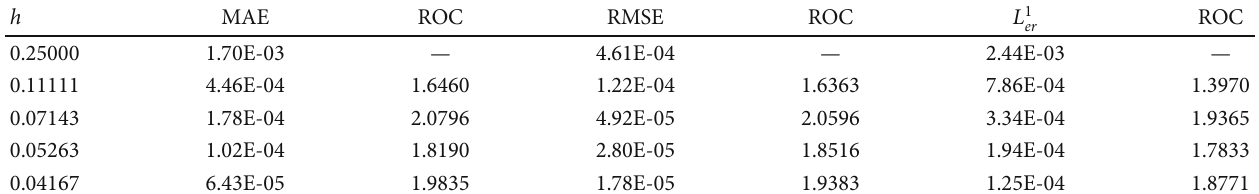
Figure 9: Maximum absolute errors vs. N Table 12: Rate of convergence for wave Example 4 using ε = 0 : 1 :